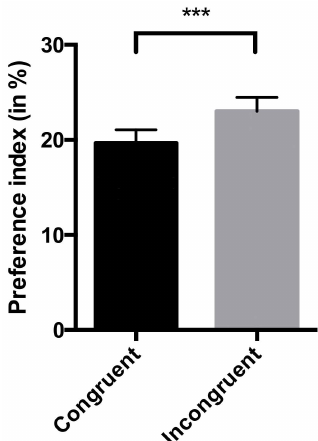
Figure 2. E ff ect of the congruence of each picture with the vocalization played on the preference index (i.e., the percentage of time spent looking at each picture) for that picture. Significance was assessed by a generalized linear mixed model: *** p < 0.001.